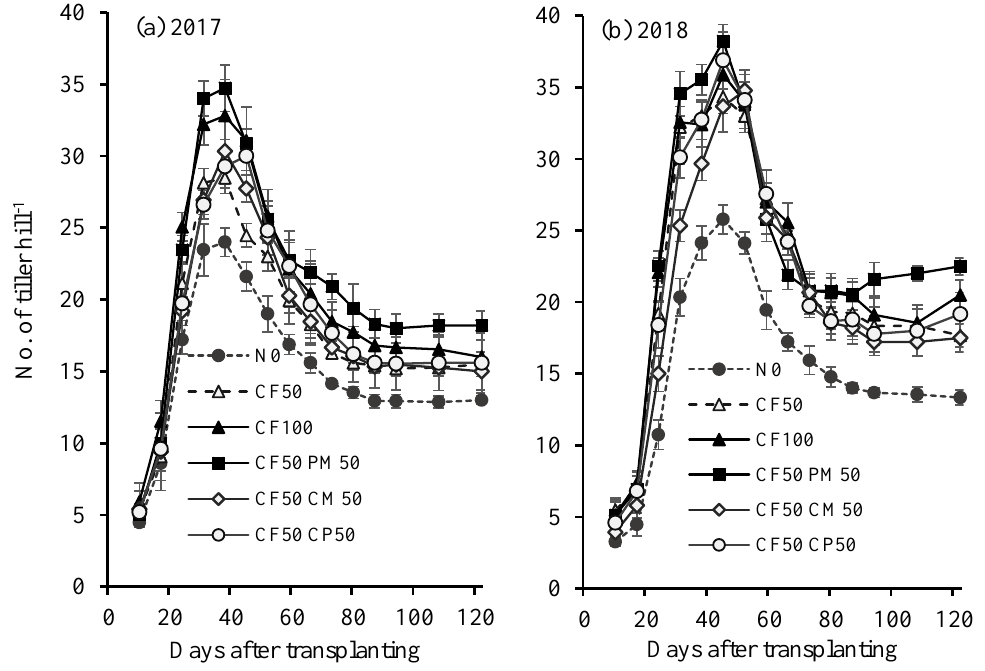
Figure 2. Tiller number of rice variety Manawthukha affected by organic fertilizers. Vertical bars represent the SD of three samples .